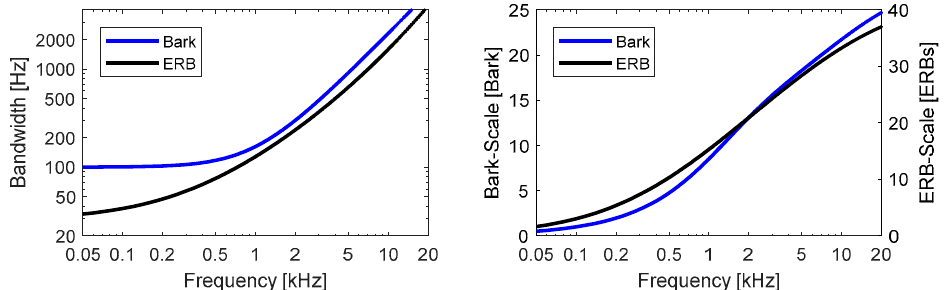
Figure 2. Critical Bandwidth and resulting perceptual scales, as modeled by the Bark-Scale and Equivalent Rectangular Bandwidth